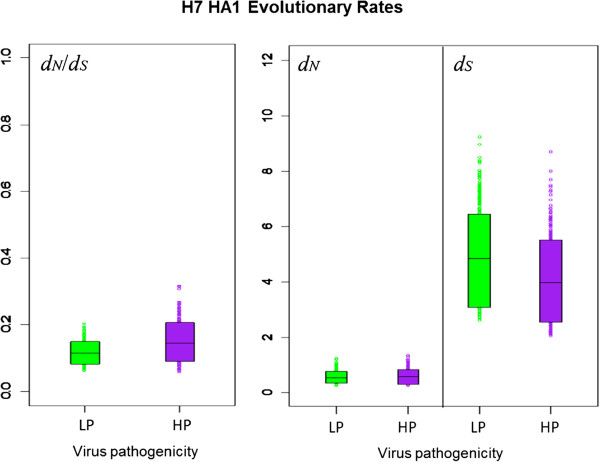
90% HPD plots for H7 HA1 evolutionary rates, split by virus pathogenicity. The coloured boxes show the limits of the narrowest interval containing 90% of the posterior estimates. The horizontal lines inside the boxes indicate the location of the mean for highly pathogenic (HP) or low pathogenic (LP) viruses. The similarity in evolutionary rates for HP and LP viruses can be observed from the overlap in the distributions and the location of the means of the distribution for HP viruses within the 90% HPD limits of the corresponding LP distribution and vice versa.